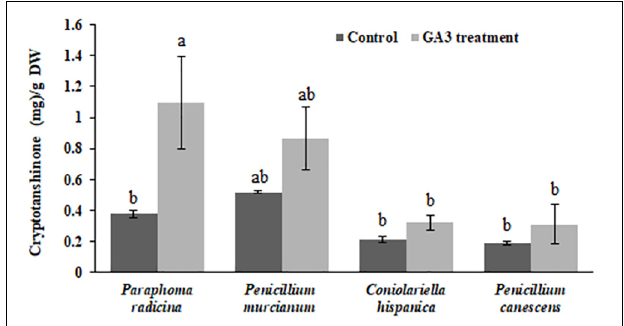
FIGURE 3 | Increase of fungal cryptotanshinone production after GA 3 treatments. Each isolate without GA 3 treatment was considered as a control. Each value represents the mean ± standard error of three replicates; small letters (a and b) indicate significant differences at P < 0.05. The experiments were conducted with three biological replicates for each